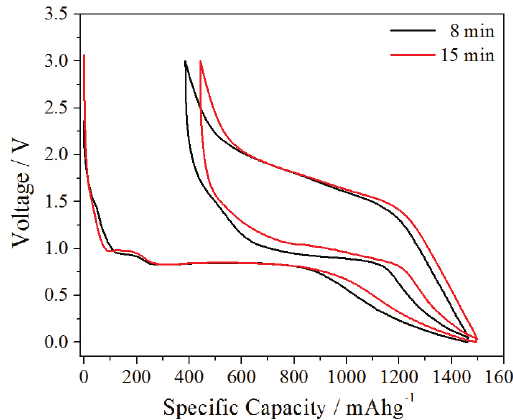
Figure 3. Voltage profiles of Fe